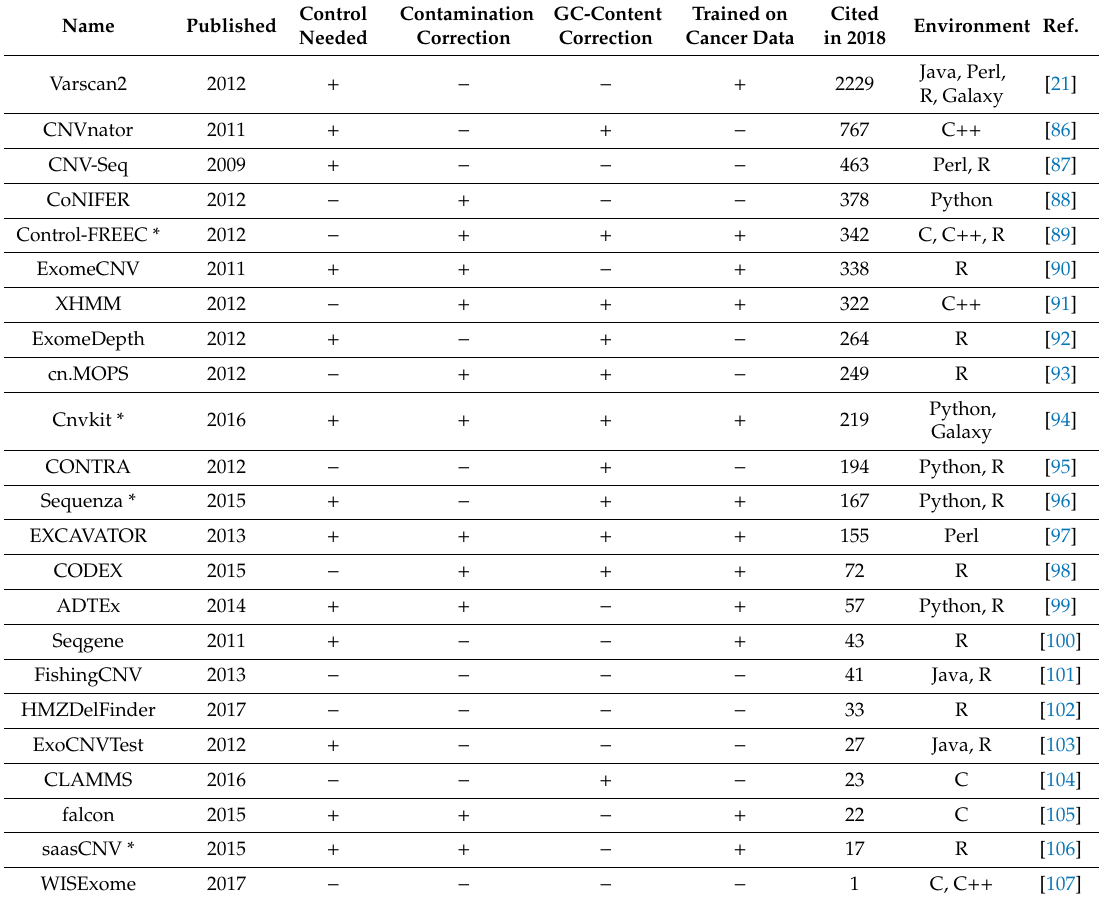
Table 3. Computational methods available for copy number variation estimation from whole exome sequencing data. Tools marked with an asterisk are suitable for both WGS and WES data